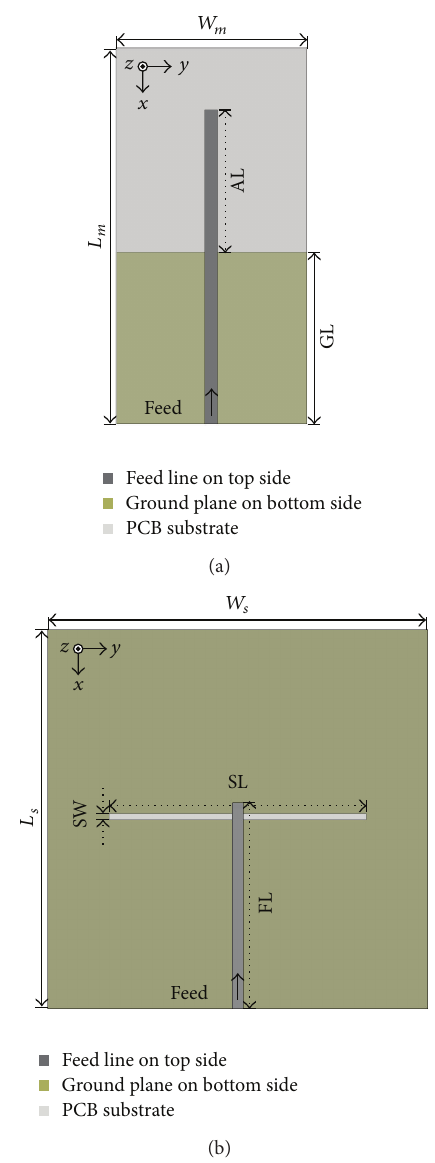
Figure 2: Geometry of the reference antennas; (a) the monopole antenna and (b) the slot